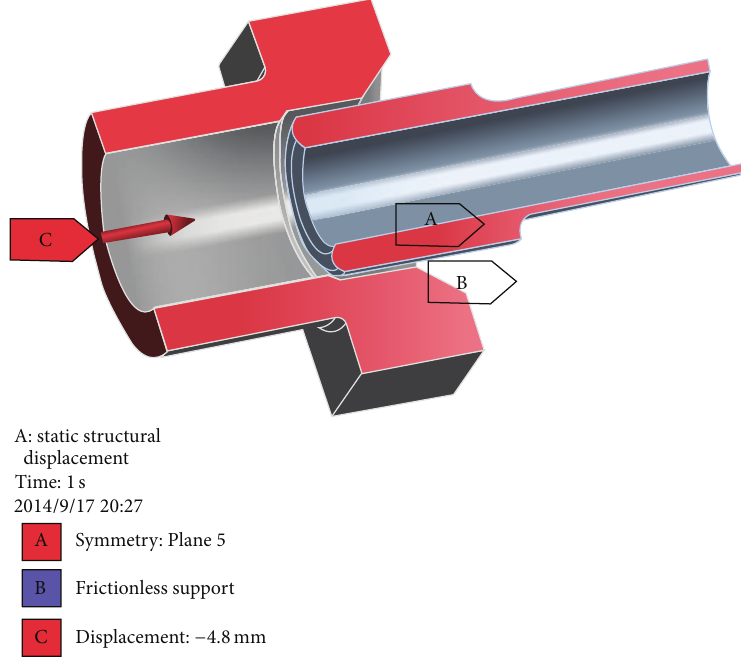
Figure 2: Load and boundary conditions.